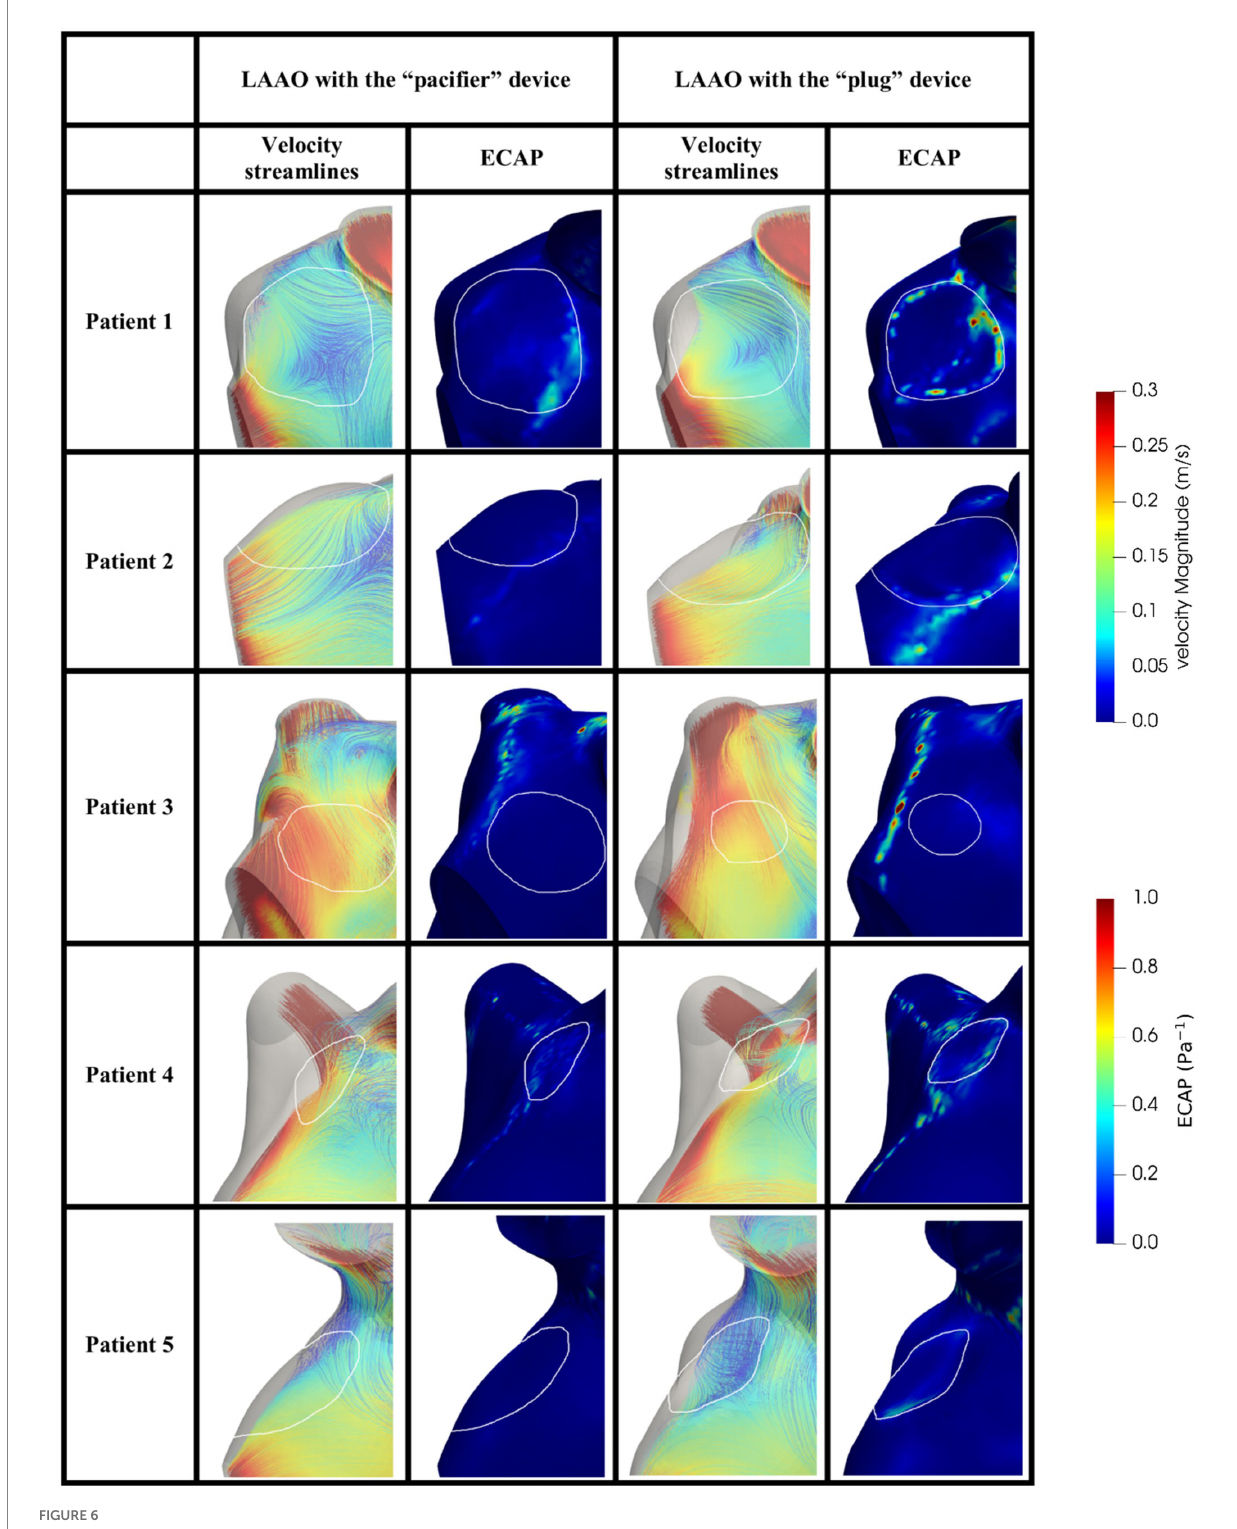
FIGURE 6 Blood velocity streamlines (first/third column) and ECAP map (second/fourth column) in the volume close to the occluder based on the pacifier/plug principle in the five patients enrolled in the study. White contours define the device location. ECAP maps were normalized considering the maximum ECAP